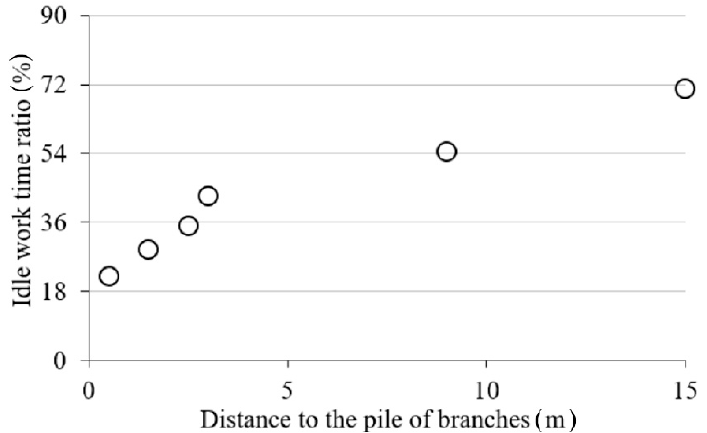
Figure 6. Characteristics of the impact of branch pile distance from the chipper on the idle run time ratio during chipping.